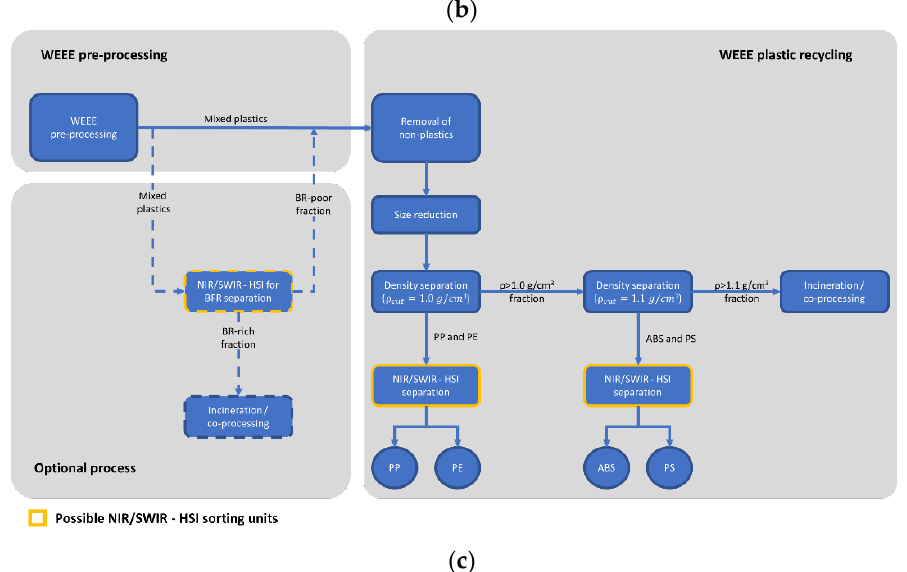
Figure 1. Conventional recycling process of WEEE plastics ( a ), possible scenarios for quality control applications by NIR/SWIR portable devices and HSI-NIR/SWIR systems ( b ), and sorting solutions adopting HSI-NIR/SWIR platform ( c ). Adapted from Haarman et al. (2020).